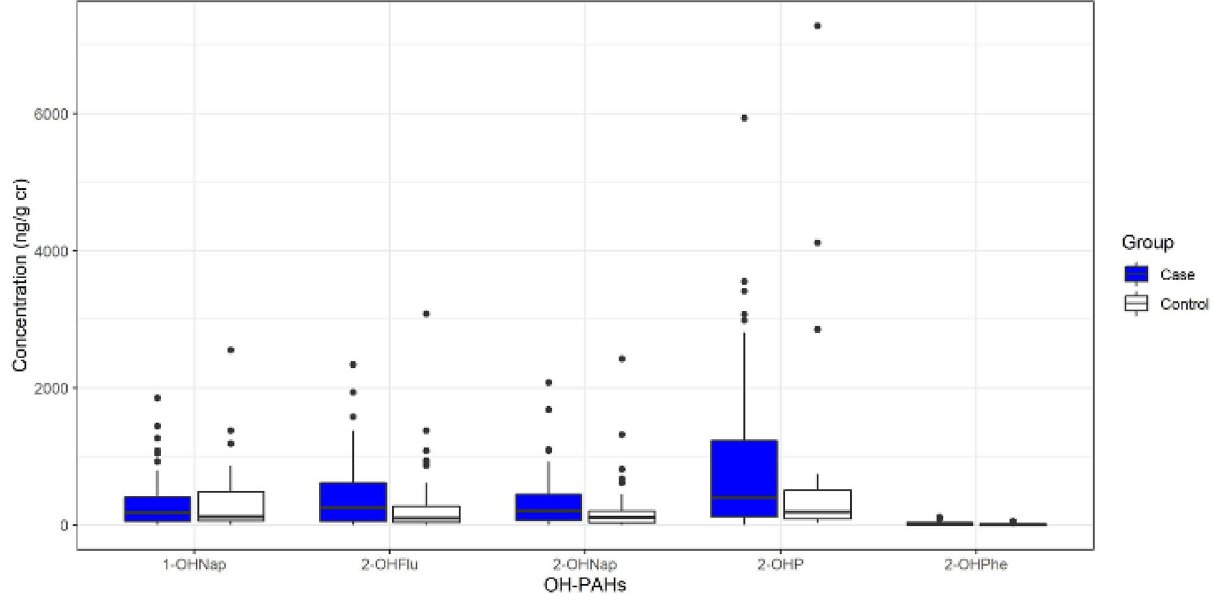
Figure 1. Box plot of creatinine-corrected urinary OH-PAHs in the people living near restaurants and the control group.